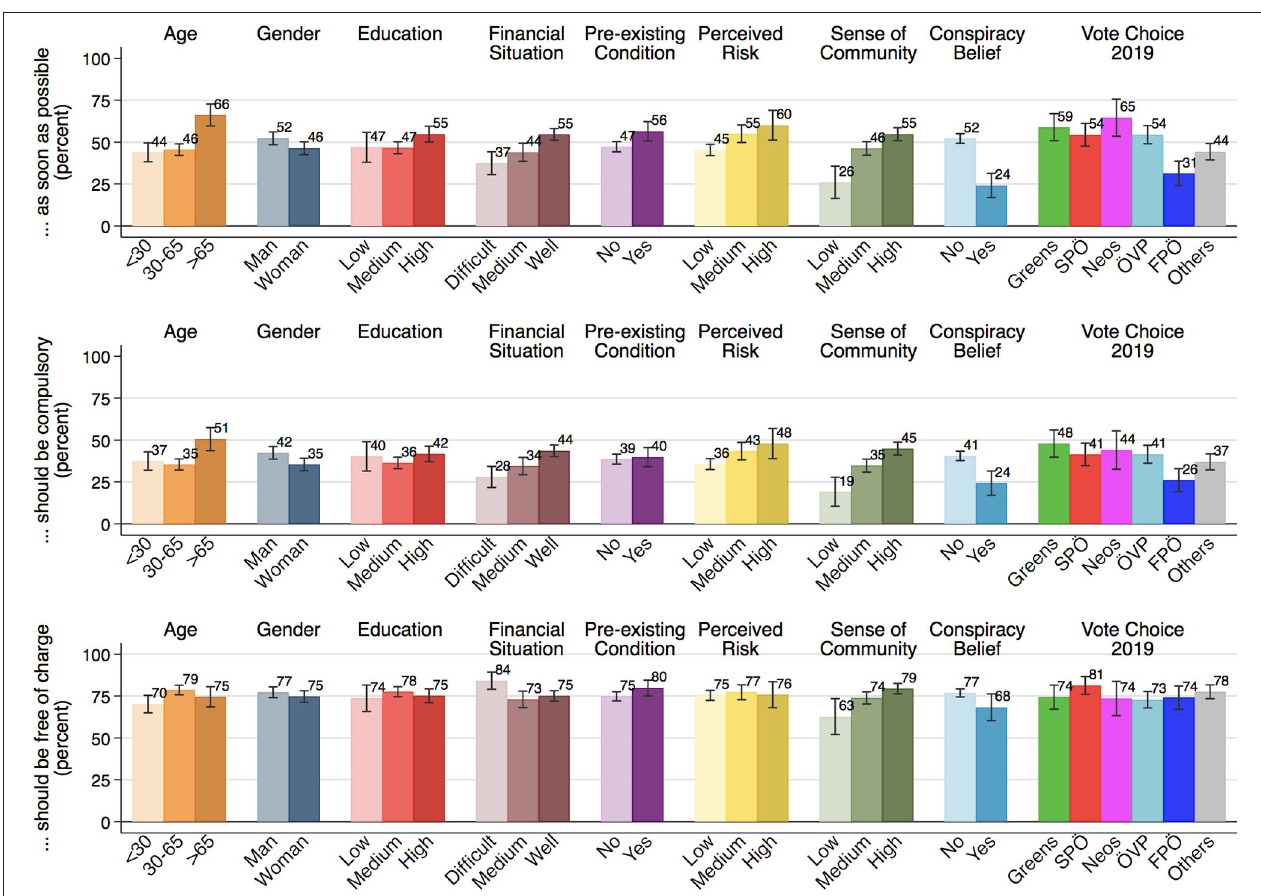
FIGURE 2 | The role of socio-demographics, health risk, social cohesion, and politics. The bars show the percentages of the categories “completely agree” and “somewhat agree” combined, alongside 95% confidence intervals (ACPP data; N = 1,301; 23–27 May 2020;